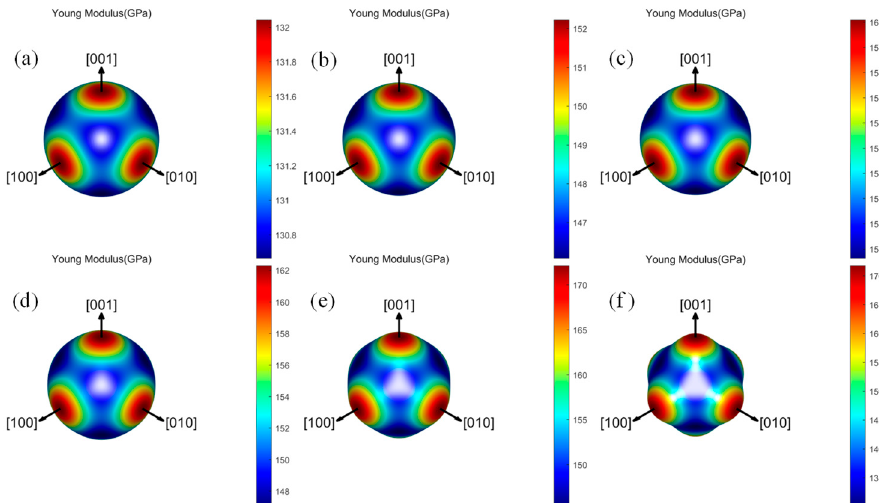
Figure 9. The Young’s modulus 3D surface of Ta–W–Hf alloys with di ff erent W contents: ( a ) Ta–